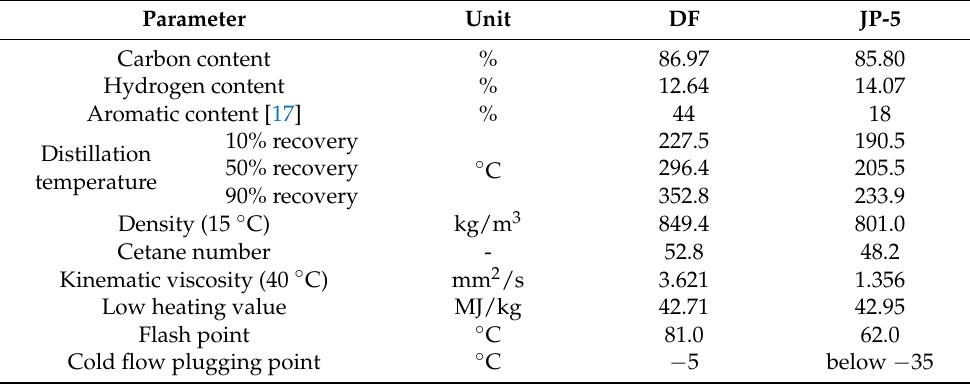
Table 2. Important physicochemical peculiarities of the test fuels.